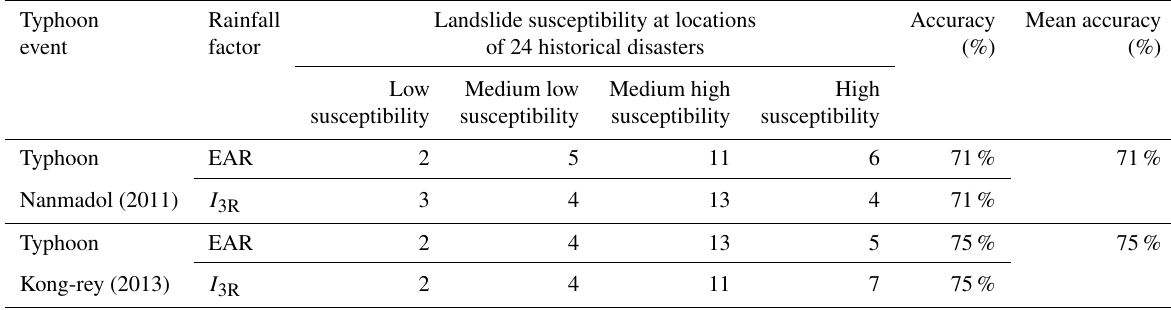
Table 8. Accuracy of landslide susceptibility map for different rainfall factors and typhoons. Typhoon